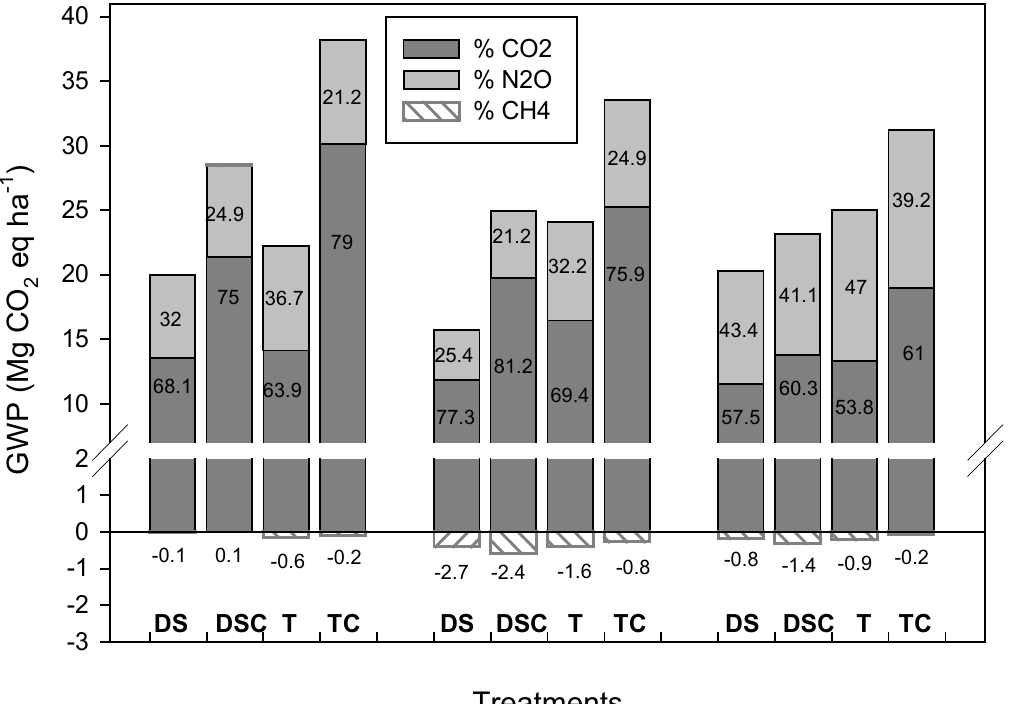
Figure 2. Contribution of each gas to the GWP for the different managements (%). Rice cultivated by: DS, direct seeding; DSC, direct seeding compost; T, tillage; and TC, tillage compost. GWP : global warming potential.